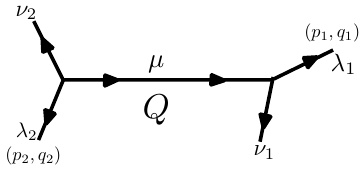
Figure 11 . The gluing rule of two